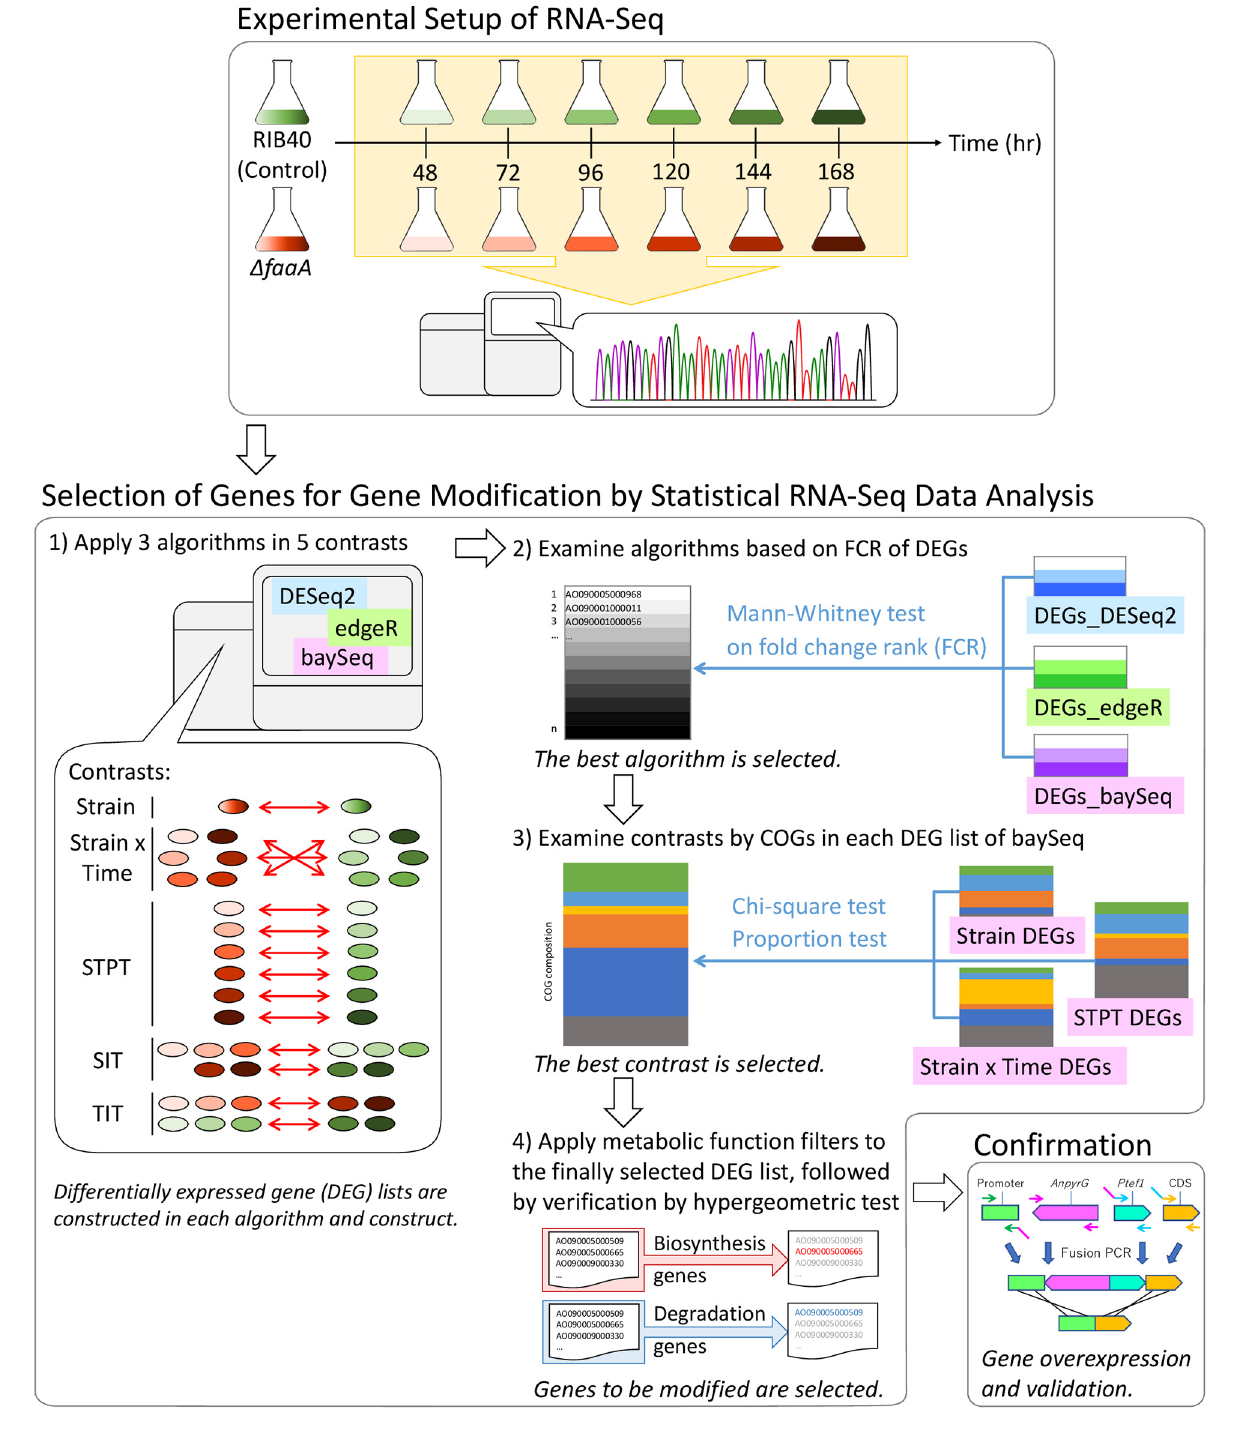
FIGURE 1 | Flow chart of the methodology used to select candidate genes for genetic modification for increasing FFA secretory productivity. Genome-scale RNA samples were prepared in 24 h intervals, from 48 to 168 h, from the RIB40 control and (cid:49) faaA strains. RNA samples were subjected to RNA-Seq and processed into normalized gene expression data for analysis. Analysis started with the extraction of differentially expressed genes by three algorithms (DESeq2, edgeR, and baySeq), followed by their comparison after being separated into five contrast categories: Strain, Strain × Time, Single Time Point (STPT), Strain Impact (SIT), and Time Impact (TIT). The resulting gene lists were analyzed by the Mann–Whitney test, and the results from the most robust method were further analyzed using clusters of orthologous groups (COG). Finally, the results were refined using functional gene lists ( Supplementary Table 1 ) to reduce the number of final candidates that were then verified by genetic